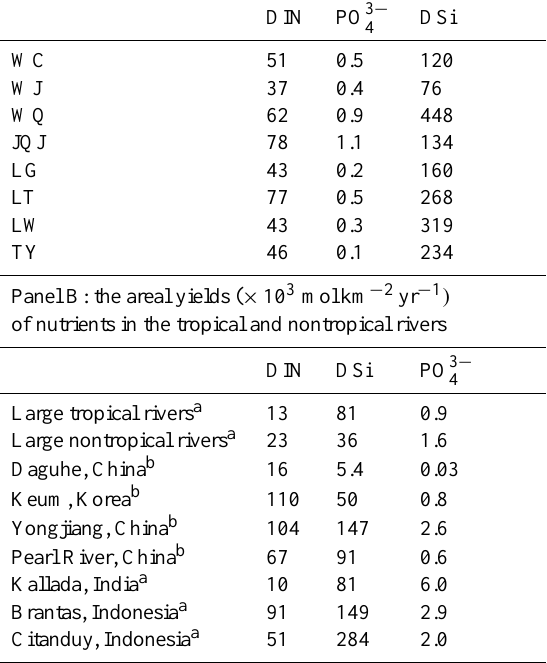
Table 3. (A) Observed nutrient yields (Obs.) ( × 10 3 mol km − 2 yr − 1 ) in rivers of the eastern Hainan Island. (B) Areal nu- trients yields (×10 3 molkm − 2 yr − 1 ) for tropical and nontropical rivers Data sources: a , Jennerjahn (2012); b , Liu et al. (2009). Panel A: observed nutrient yields ( × 10 3 molkm − 2 yr − 1 ) of rivers along the eastern Hainan Island DIN